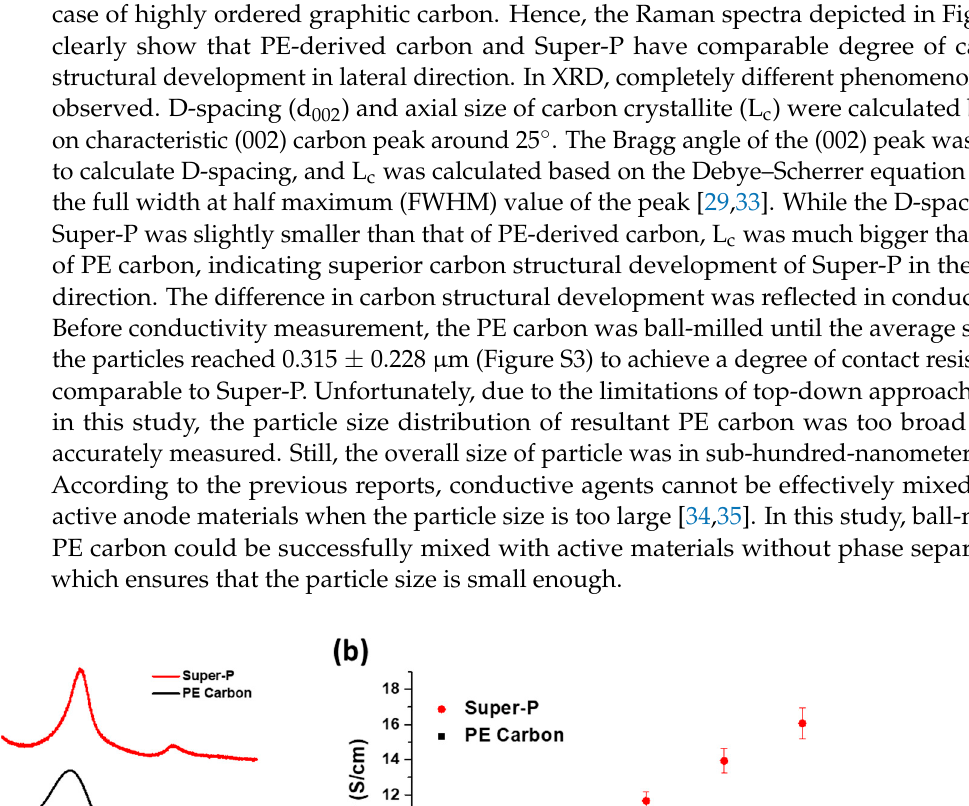
Figure 4. ( a ) Raman spectra of carbon derived from sulfonated PE (PE carbon) and SuperP. ( b ) Thermogravimetric analysis (TGA) results for sulfonated PE.